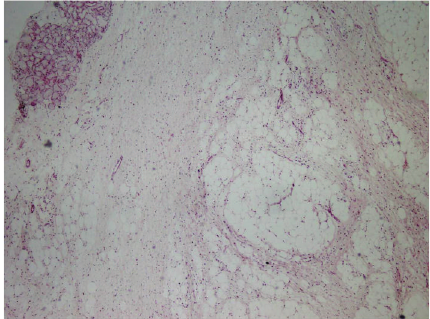
Figure 3: The lesion contained myxoid centres, collagen bands, adipocytes, and spindle cells with a nearby minor salivary gland (H&E × 100).